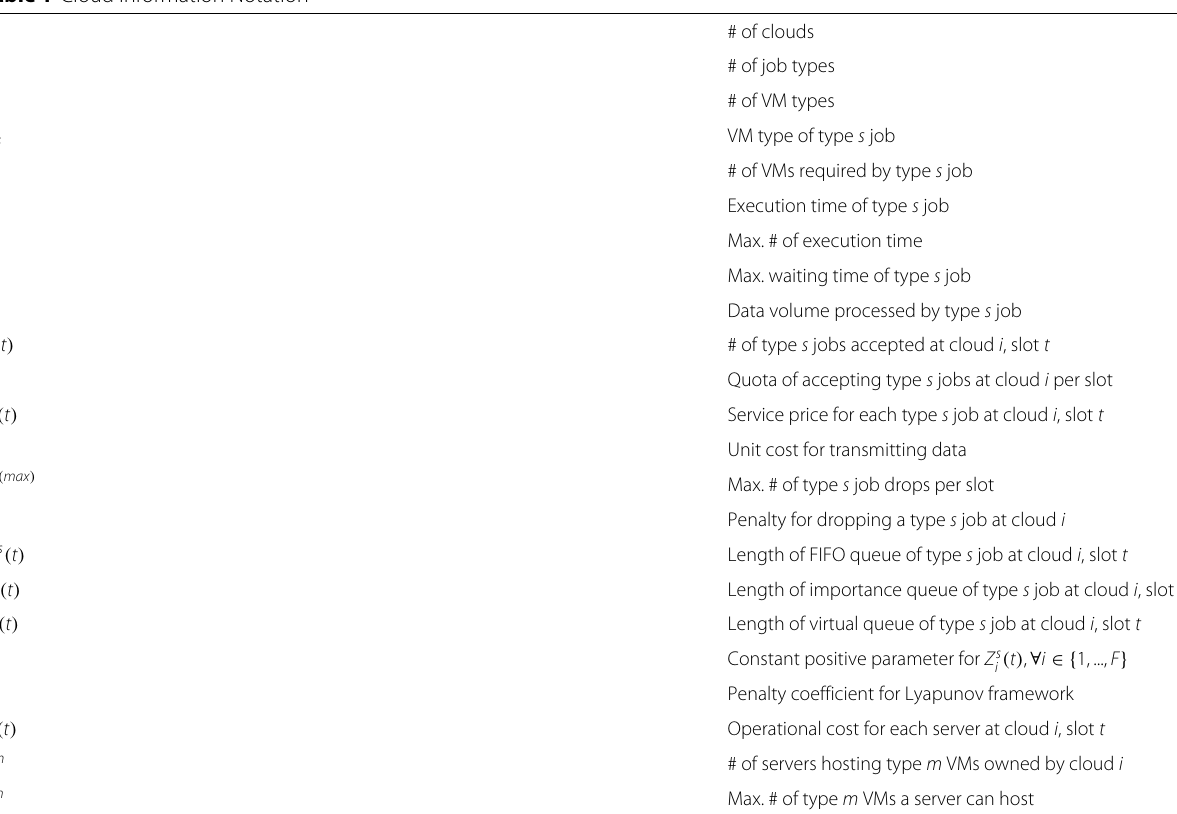
Table 1 Cloud Information